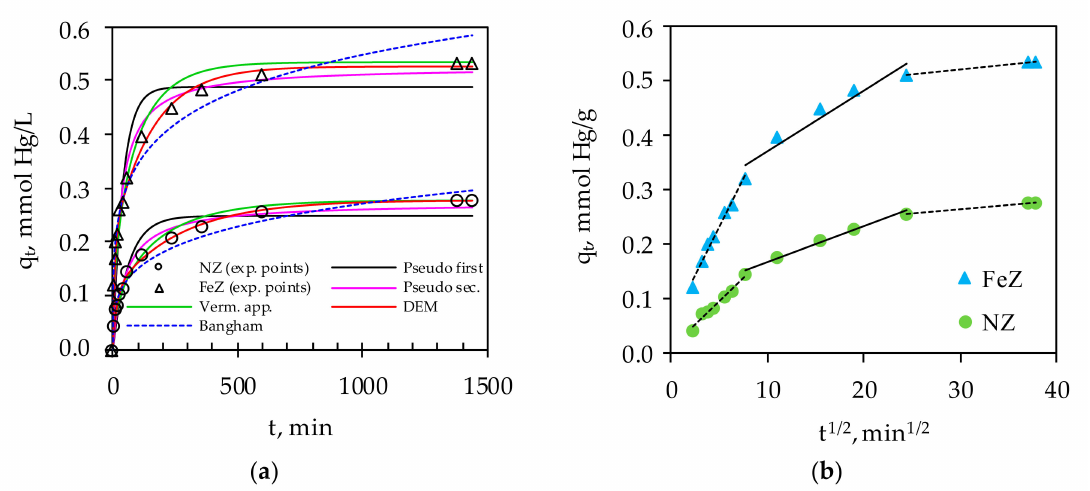
Figure 6. ( a ) Fitting of experimental data with Pseudo-first-order model (PFO), Pseudo-second-order (PSO), Vermeulen’s approximation, double-exponential model (DEM), and the Bangham model. ( b ) Fitting of experimental data with the Weber–Morris